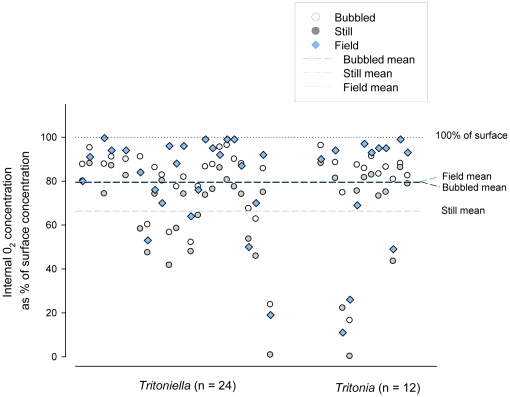
Internal O2 in masses in the field and the lab.Internal O2 in individual masses of two Antarctic nudibranch species, Tritonia challengeriana and Tritoniella belli, measured under three conditions; in the field (blue diamonds), equilibrated in the lab under bubbled conditions (open circles), and in the lab in still water (filled circles). The combined means of all field (blue dashed line, x = 79.9% of ambient), lab bubbled (black dashed line, x = 79.5%), and lab still water (grey dashed line, x = 66.3% of ambient) measurements for both species are also shown.